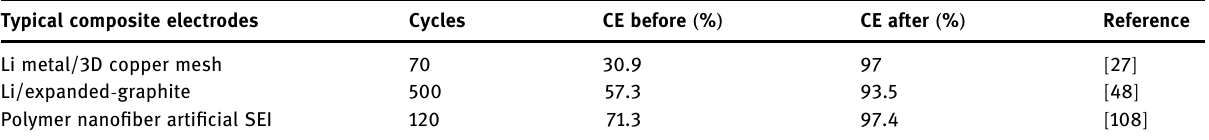
Table 1: Coulombic e ffi ciency improvement comparison of the selected typical composite electrodes tested before and after modi fi cation Typical composite electrodes Cycles CE before ( % ) CE after ( %